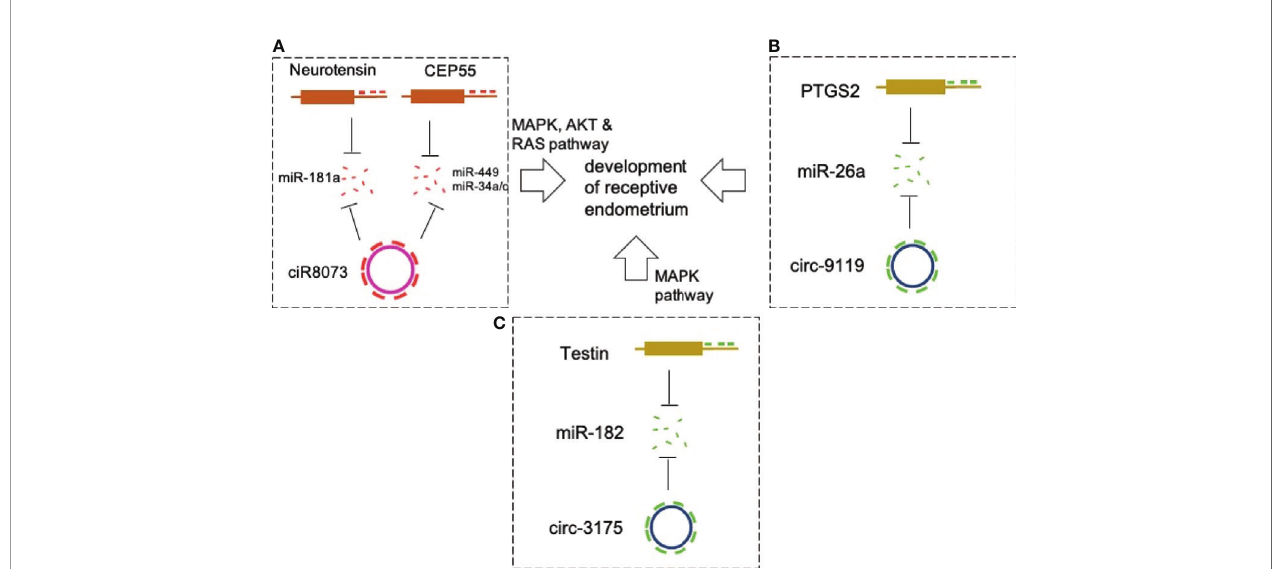
FIGURE 2 | CircRNAs in endometrial receptivity. (A) CiR-8073 functions as a ceRNA to sequester miR-181a, thereby protecting neurotensin from miR-181a-mediated suppression in EECs. Circ-8073 regulates endometrial receptivity via miR-181a/neurotensin and miR-449a/CEP55 and miR-34/CEP55 axes. (B) Modulation of the circRNA-9119-miR-26a-PTGS2 axis in EECs may be a potential target for regulating RE development. (C) The ciR3175-miR182-testin axis is essential for development of pre-receptive endometrium in